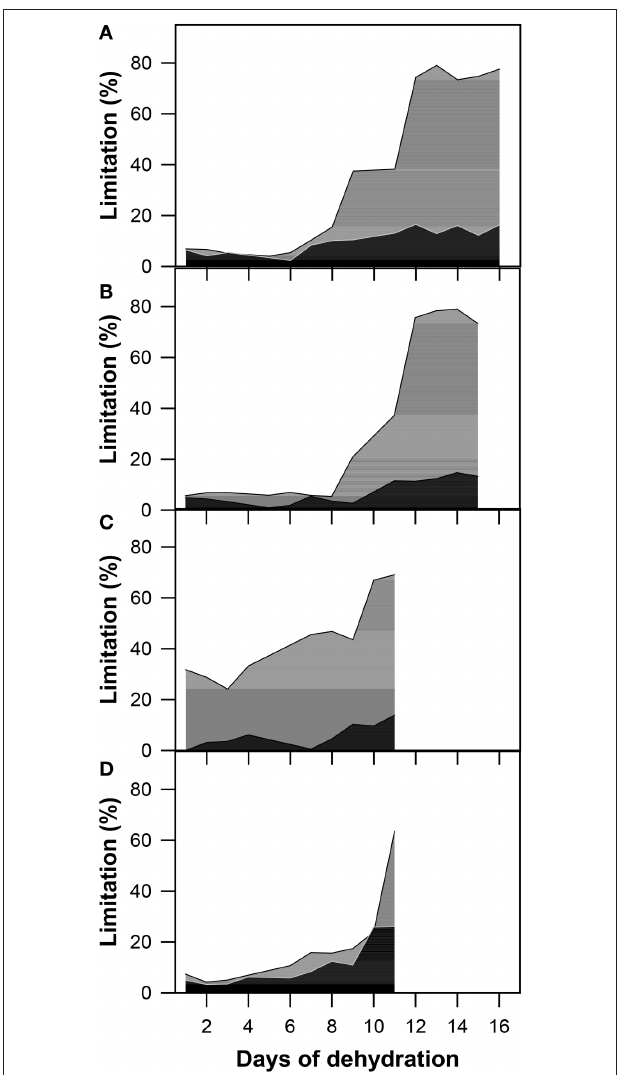
FIGURE 7 | The stomatal (L S ; black) and mesophyll (L M ; gray) limitations to the A N calculated as the % of the maximum (well-watered) values in (A) GK Forrás, (B) Pehlivan, (C) Piopio-4, and (D) Šamorínska genotypes under progressive drought. Each value represents the mean of four